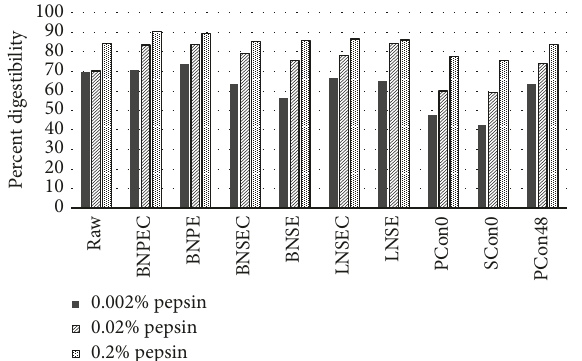
Figure 4: Pepsin digestibility of select samples at three pepsin concentrations. B: baker’s yeast, L: L. kononenkoae , N: nitrogen supplement; P: pasteurized; S: sterilized; E: enzyme; C: coculture; Con: control samples at 0 and 48 hours.